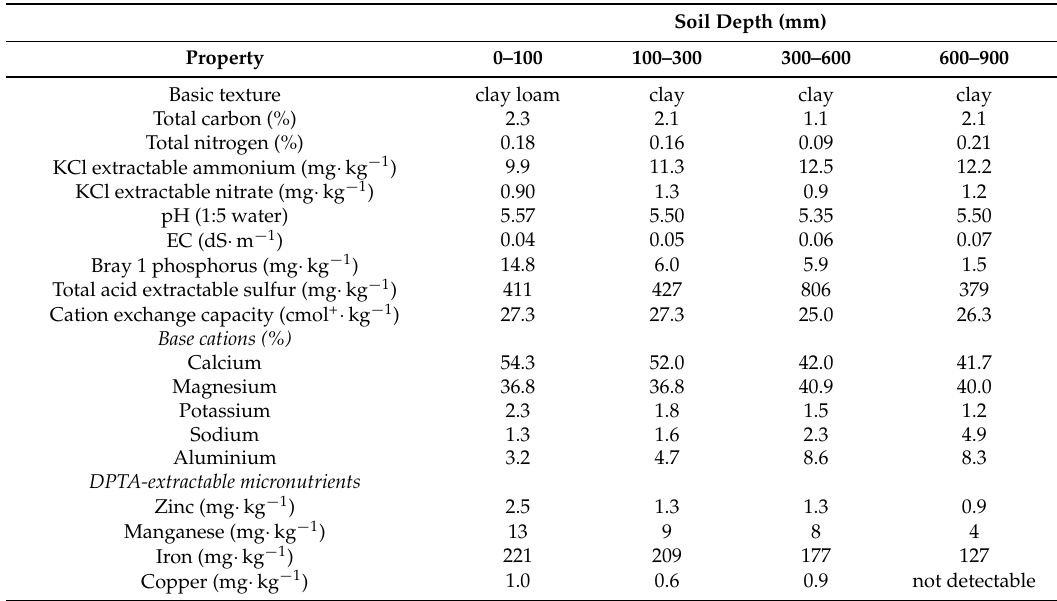
Table 2. Selected physiochemical properties of the 0–100 mm, 100–300 mm, 300–600 mm and 600–900 mm horizons at the Woodburn field